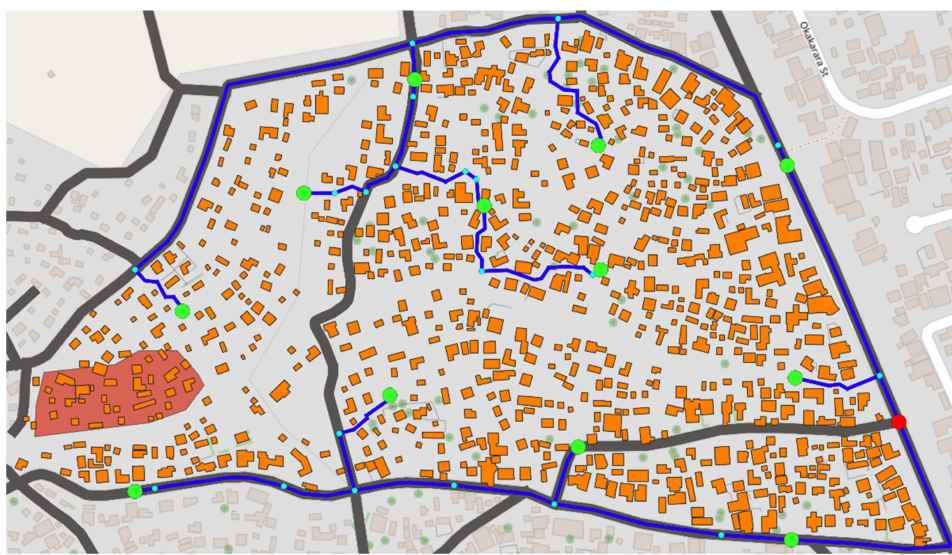
Figure 9. Result of the generated WDS (pipes: blue, water: points green, feeding point: red) where a cost factor of f road = 0.1 was applied for routing along existing paths/roads. (basemap and buildings/polygons: